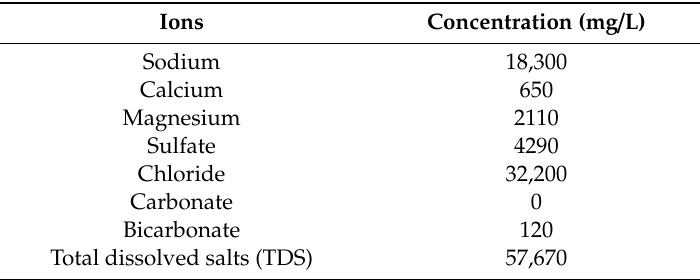
Table 2. Synthetic gulf water composition [44].